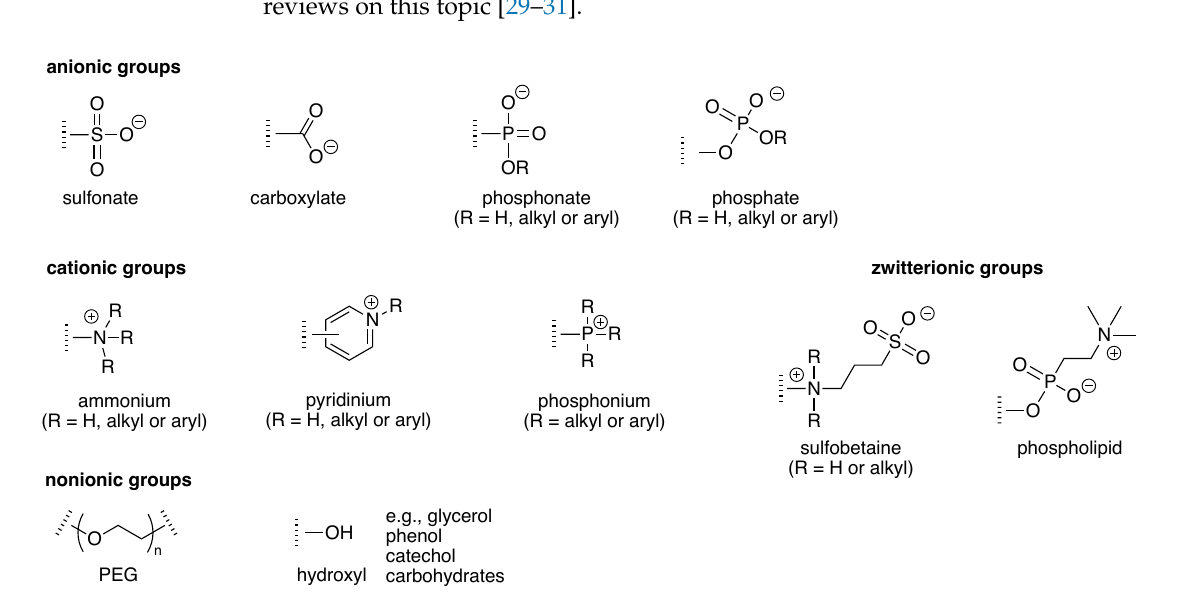
Figure 7. Diverse groups for water solubilization.